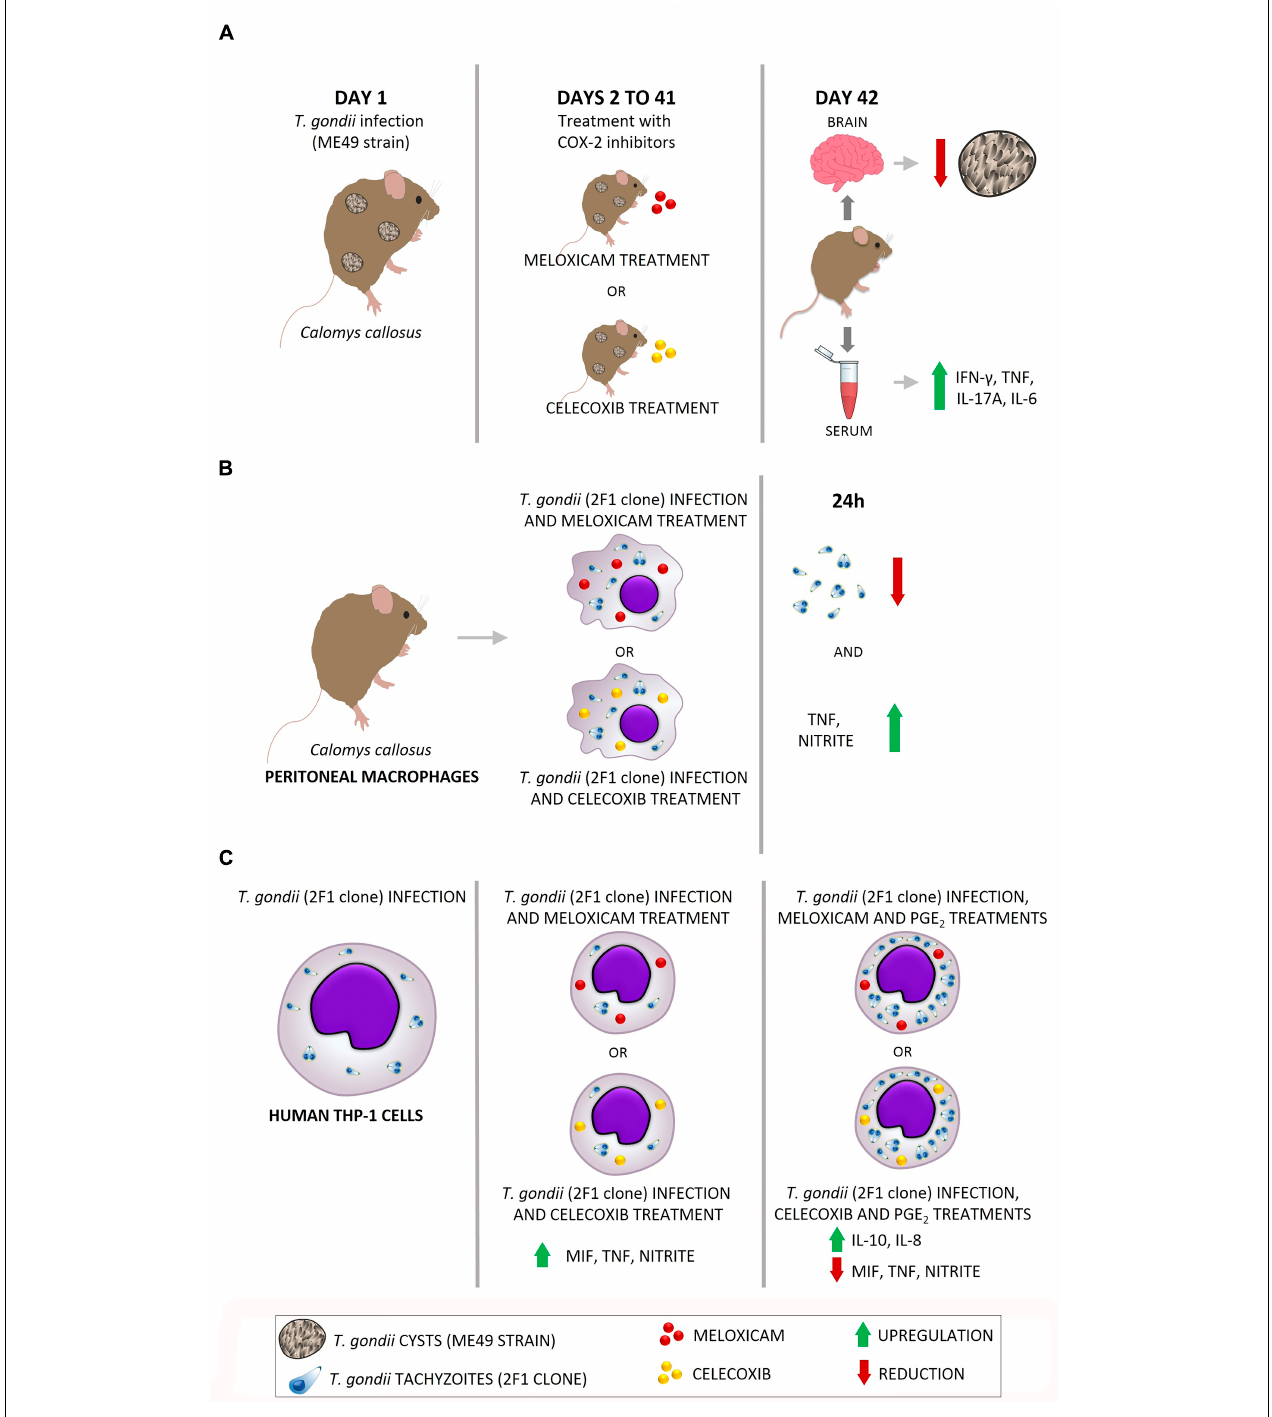
FIGURE 8 | Proposed model of actions induced by COX-2 inhibitors in in vivo and in vitro experimental models. (A) C. callosus infected with T. gondii (ME49 strain) and treated with COX-2 inhibitors presented reduced parasite burden in brain and upregulation of pro-inflammatory cytokines (IFN- γ , TNF, IL-17A, and IL-6). (B) C. callosus -peritoneal macrophages treated with COX-2 inhibitors and infected with T. gondii (RH strain) demonstrated a reduced parasite intracellular proliferation and upregulation of pro-inflammatory mediators (TNF and nitrite). (C) THP-1 cells treated with COX-2 inhibitors and infected with T. gondii (RH strain) (middle panel) presented reduced parasite proliferation and upregulation of pro-inflammatory mediators (MIF, TNF, and nitrite) in comparison to untreated/infected cells (left panel); while THP-1 cells treated with COX-2 inhibitors plus exogenous levels of PGE 2 (right panel) demonstrated increased parasitism, upregulation of IL-10 and IL-8, and downmodulation of pro-inflammatory mediators (MIF, TNF, and nitrite).